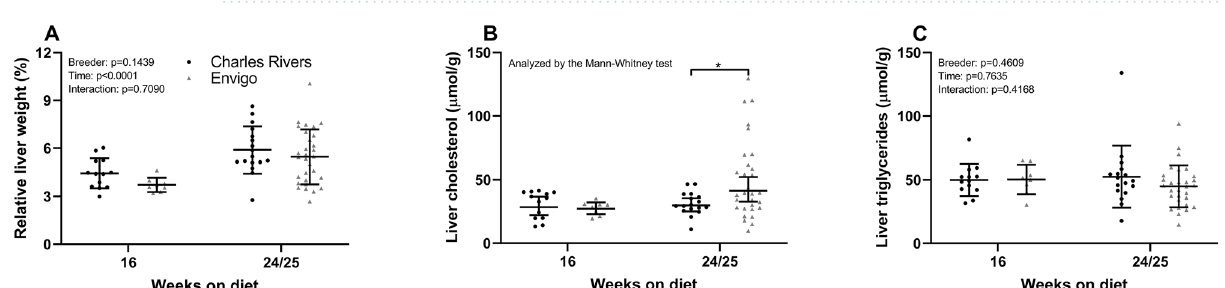
Figure 4. Liver weight and lipid content. ( A ) Liver weight relative to bodyweight did not differ between Charles River and Envigo animals. ( B ) Envigo animals displayed a higher hepatic cholesterol content compared with Charles River at week 25, ( C ) while liver triglyceride levels were not different between breeders. Means with standard deviations. *p < 0.05 compared between breeders at the same time-point. Analysed by 2-way ANOVA ( A , C ) or Mann–Whitney test ( B ) as variance homogeneity could not be obtained following Overall ALP levels were higher in Charles River animals (p breeder < 0.0001) with post-hoc comparison showing a significant difference at week 24/25 (p < 0.0001). Plasma cholesterol was higher in chow fed animals from Charles River at week 16 (p = 0.0004). To ensure that differences in disease development were not merely a reflection of different baseline values—i.e. the healthy control animals were not similar between breeders—continuous data from high fat fed animals were normalized to control animals from the same breeder at the same time-point (data not shown). Normalized data accentuated the already established differences and similarities in plasma ALT, AST, total cholesterol and free fatty acids, with normalized ALT and AST levels also being higher in Charles River animals at week 16 (p = 0.0458 and p < 0.0001, respectively) (data not shown). Following normalization, hepatic cholesterol content and plasma triglycerides no longer differed between breeders. In contrast, normalized relative liver weights were higher in animals from Charles River compared with Envigo at week 16 (p = 0.0118) and 24/25 (p = 0.0042). Normalized hepatic triglycerides were lower at week 16 (p = 0.0002) and higher at week 25 (p < 0.0001) in guinea pigs from Charles River compared to Envigo. Normalized ALP at week 25 were lower in guinea pigs from Charles River compared with Envigo (p = 0.0166). Hepatic gene expression. At week 16 Ccl2 [also known as monocyte chemoattractant protein 1 ( Mcp1 )], Pdgfb and Col1a1 were increased approximately 3.5-, 2- and 2.5-fold in Charles River animals with NASH com- pared to Envigo, respectively (p = 0.0030, p = 0.0008 and p = 0.0253, respectively) (Fig. 5A). Acta2 (α smooth muscle actin) was increased in NASH animals from Envigo compared to Charles River (p = 0.0020). At week 24/25, the inflammatory genes Ccl2 and Cxcl8 (interleukin 8) were increased approximately 4- and 3-fold in Charles Rivers NASH animals (p = 0.0002 and p = 0.004) while Tnf was nominally increased compared to Envigo